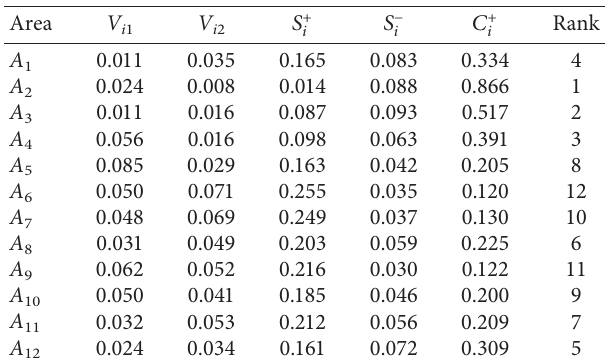
Table 5: Result of